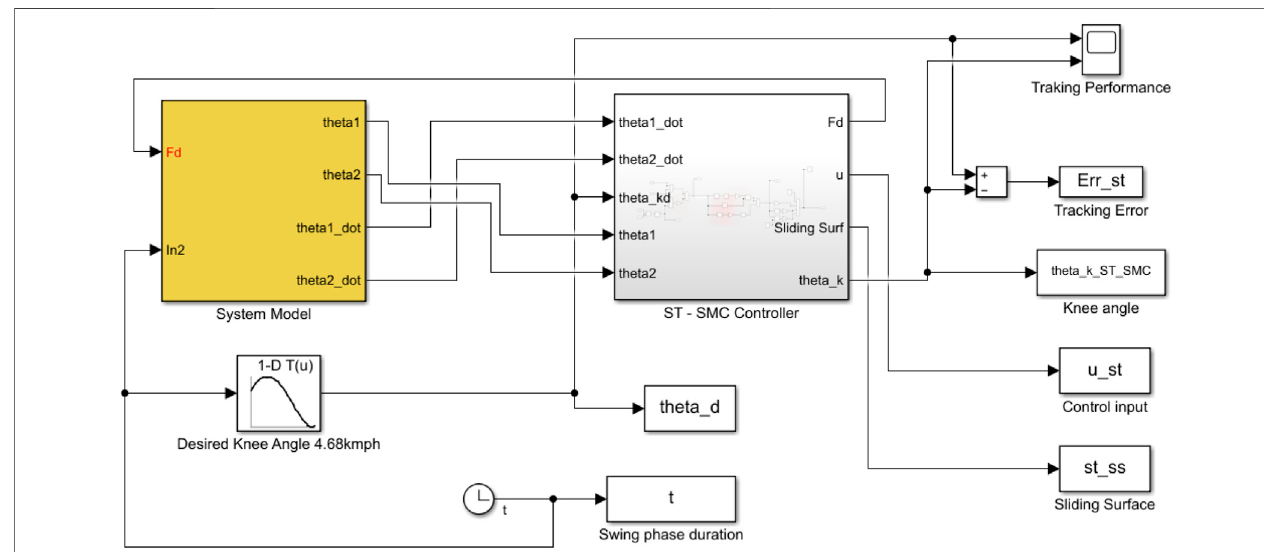
FIGURE 4 | SIMULINK block diagram of the system model and ST-SMC